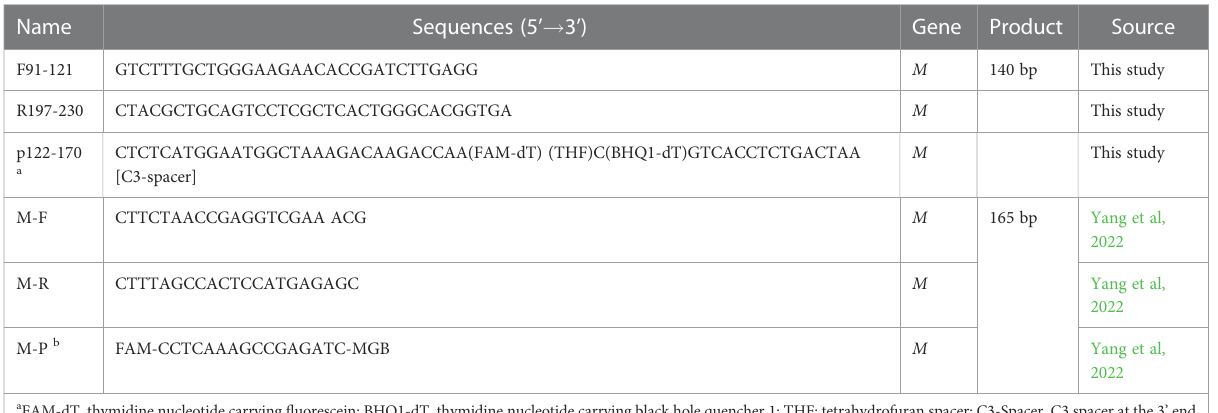
number was calculated using the following formula: DNA copy